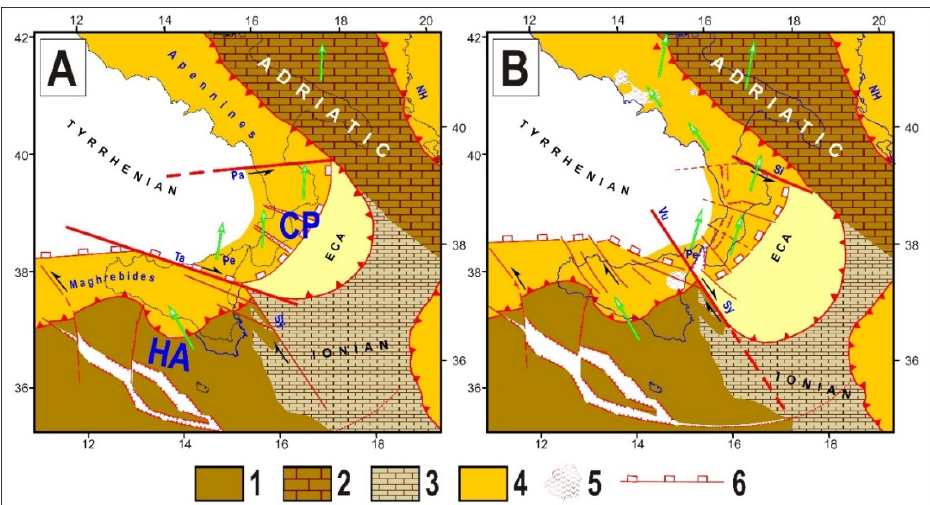
Figure 15. Tectonic sketch of the Calabria–Peloritani (CP) and Hyblean–Adventure (HA) wedges before and after the collision of Northern Calabria with the Adriatic continental domain. (1) Nubian continental domain; (2) Adriatic continental domain; (3) Ionian oceanic domain; (4) Orogenic belts; (5) Volcanism; (6) Outer fronts of the Alpine belt. ( A ) Early Pleistocene configuration. The lateral escape of the CP wedge (evidenced by yellow) is guided by the Taormina (Ta) and Palinuro (Pa) faults. NH = Northern Hellenides; Sy = Siracuse; Pe = Peloritani. ( B ) Post-middle Pleistocene tectonic setting: after the collision of Northern Calabria with the continental Adriatic domain, the extrusion trend of the CP wedge changed significantly due to the activation of two new lateral guides (Sibari (Si) and Vulcano–Syracusa (Vu-Sy) faults, e.g., [146,182,199]). The lateral guides of the CP and HA wedges are evidenced by red boldface lines. Green arrows indicate the kinematic pattern (with respect to Eurasia) which is compatible with the observed Quaternary deformations (e.g., [10,27,32] and with the present velocity field (Figure 14). Other symbols as in Figure